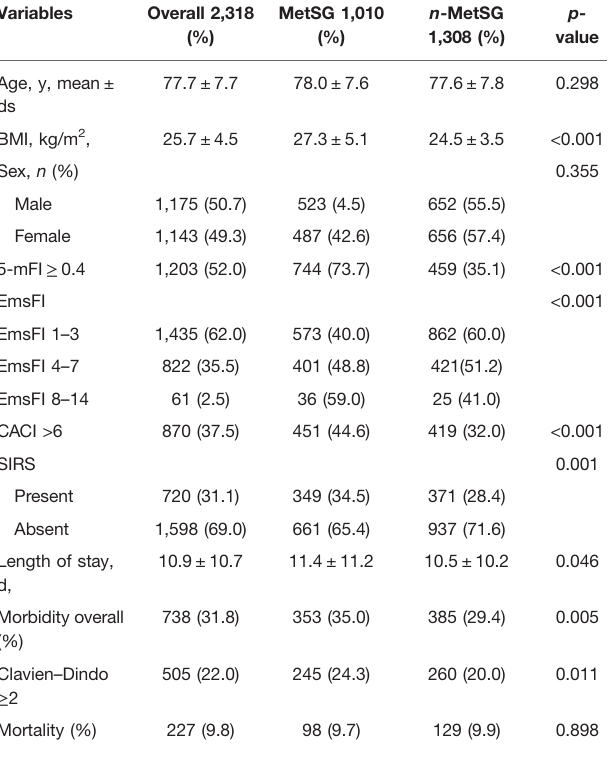
TABLE 2 | Demographics and clinical data strati fi ed by the presence of MetS with or without SIRS and Frailty. Variables